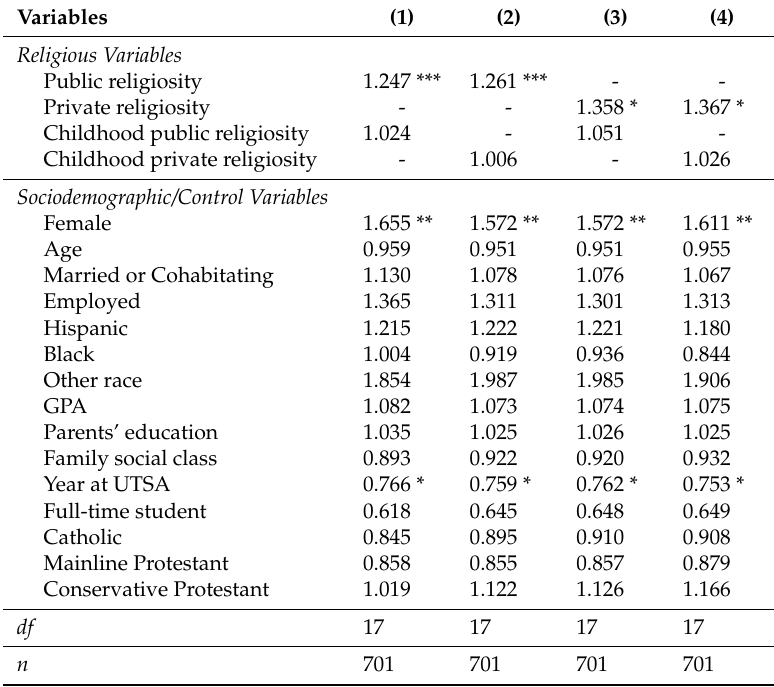
Table 3. Direct effects of emerging adulthood religiosity in logistic regression models using SEM a